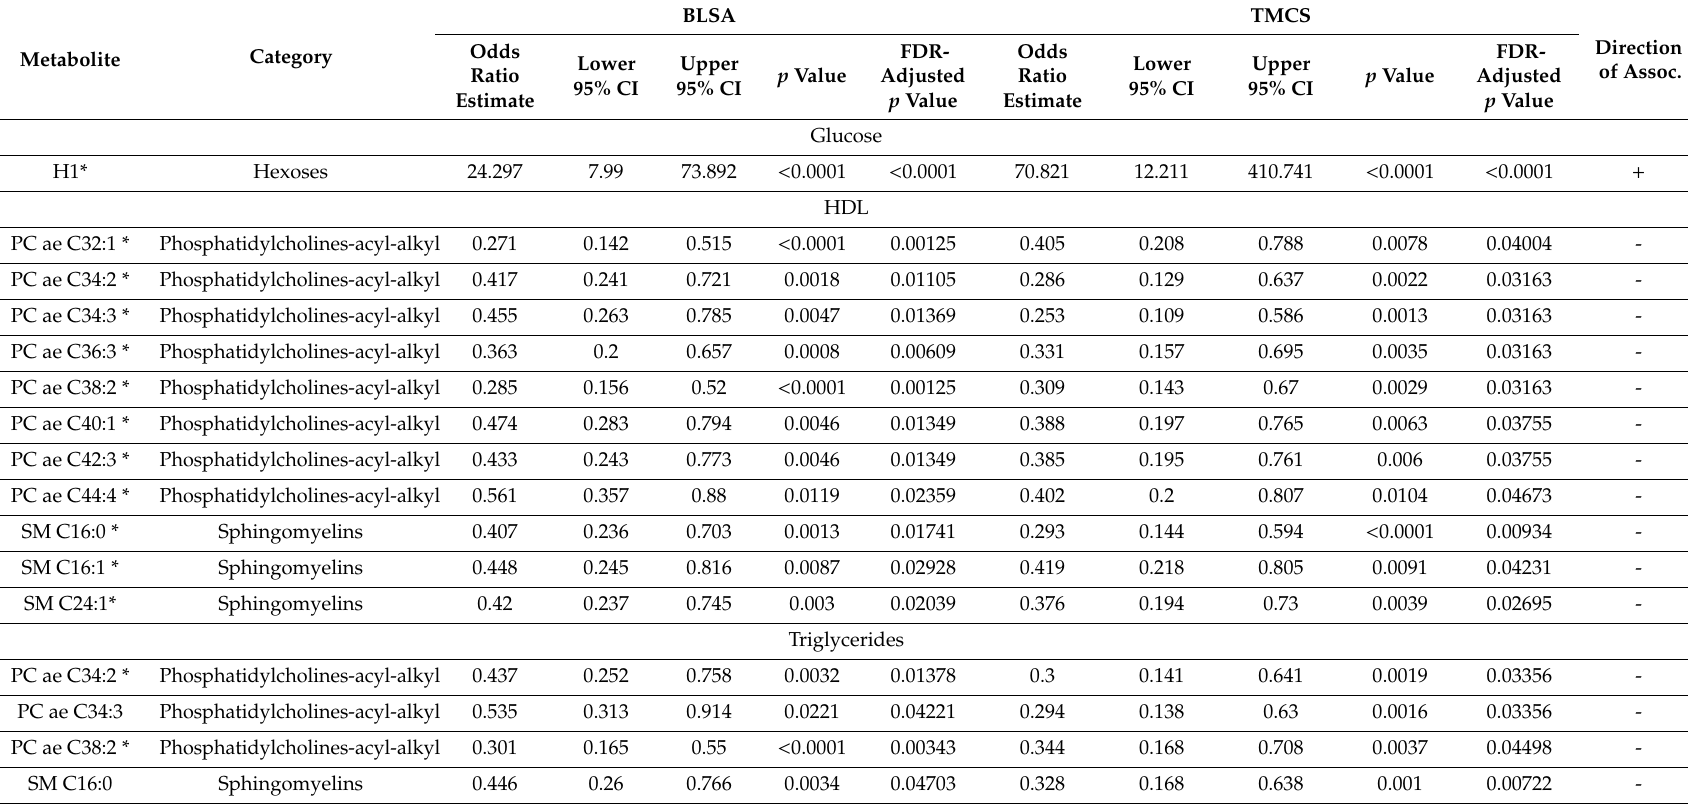
Table 3. Adjusted significant associations in both BLSA and TMCS: glucose, HDL, and triglyceride